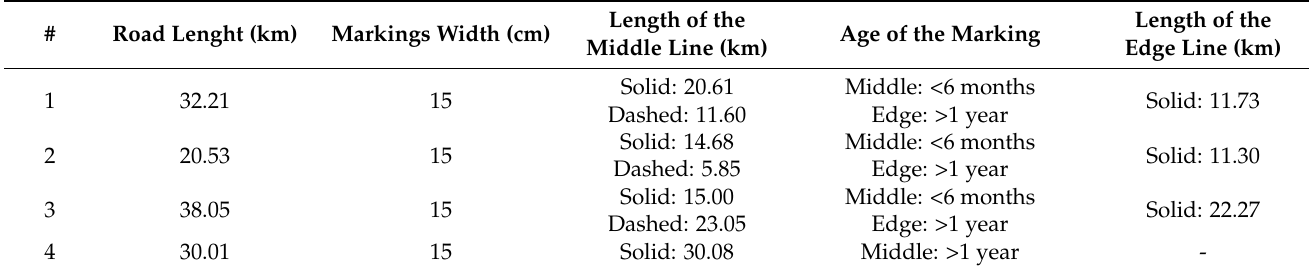
Table 1. Characteristics of test road